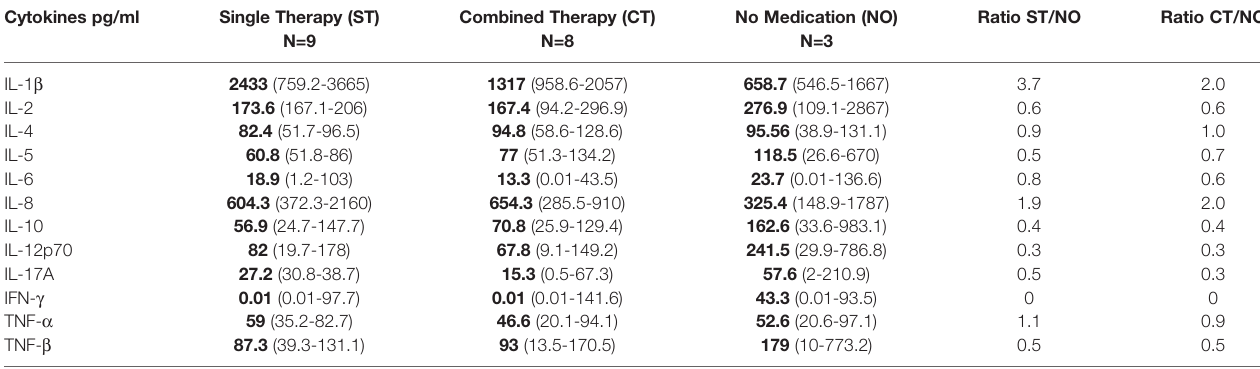
TABLE 4A | Saliva cytokine concentrations from Behc ̧ et ’ s Disease (BD) patients on Single treatment (ST), Combined Treatment (CT) or No Medication (NO). Cytokines pg/ml Single Therapy (ST)